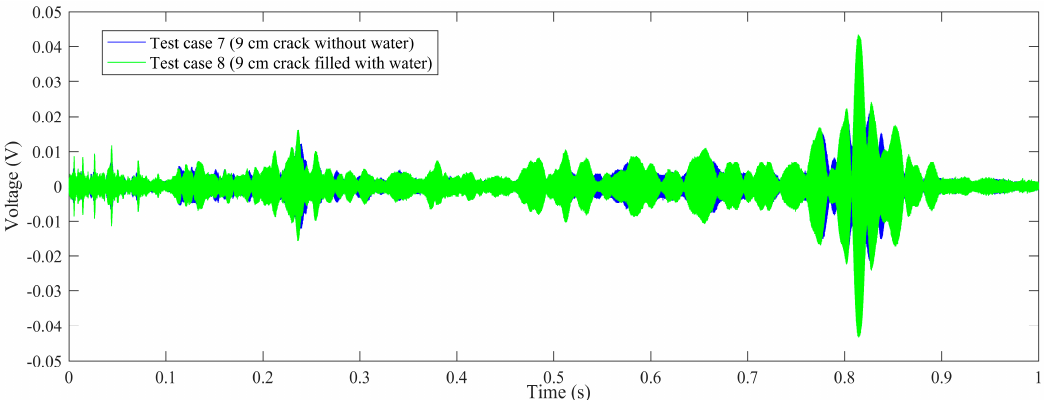
Figure 7. The comparison of voltage signals: test case 7 (9 cm crack without water), test case 8 (9 cm crack filled with water).